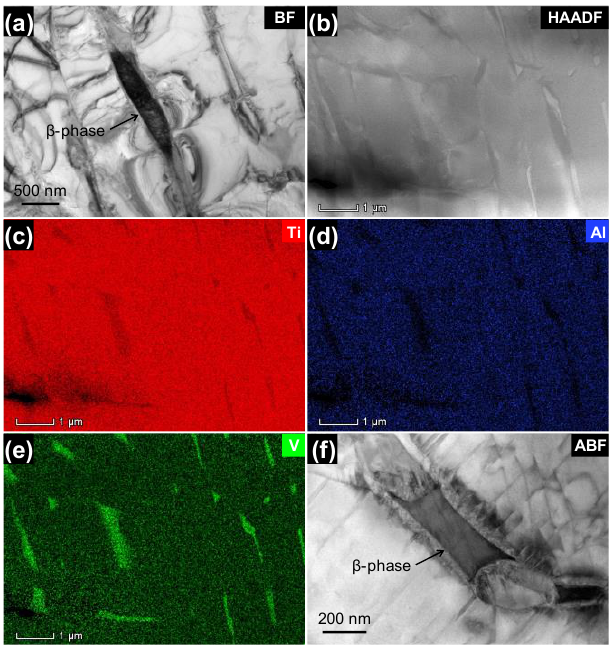
Figure 2. ( a ) BF-TEM image, ( b ) HAADF-STEM image, and corresponding STEM-EDS maps of ( c ) Ti, ( d ) Al, and ( e ) V for the as-built specimen. ( f ) Magnified ABF-STEM image showing the vicinity of the β -phase precipitate.